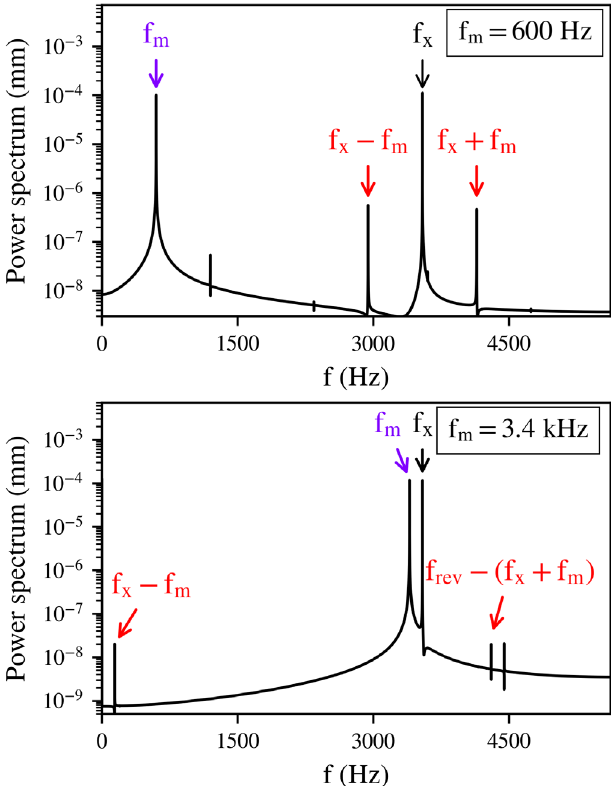
FIG. 8. Power spectrum of a single particle, which is tracked in the HL-LHC lattice, in the presence of a tune modulation at 600 Hz (top) and 3.4 kHz (bottom) that depicts the sidebands (red) around the betatron tune (black) and the dipolar excitation (purple) due to feed-down.